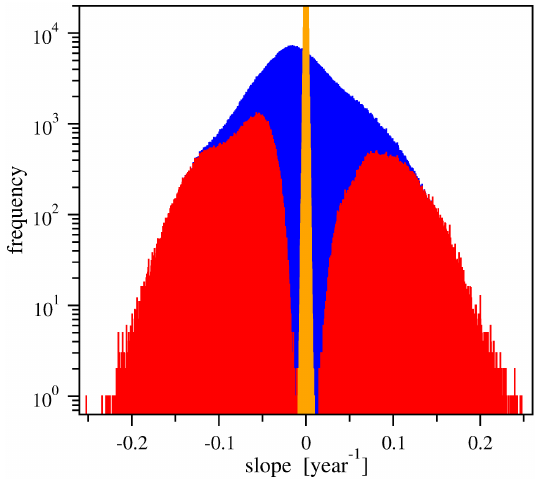
Figure 3. Histogram of all fitted slopes (blue) over the continents, where DSI data are available (4914440 locations). Its is clearly not a Gaussian shape (note the logarithmic vertical scale), the global mean value is − 0 . 00875 ± 0 . 04971year − 1 . Orange bars denote the histogram of mean slopes computed for 1000 randomly shuffled test sets for each geographic location. Red bars indicate significant slopes at 2 σ or higher